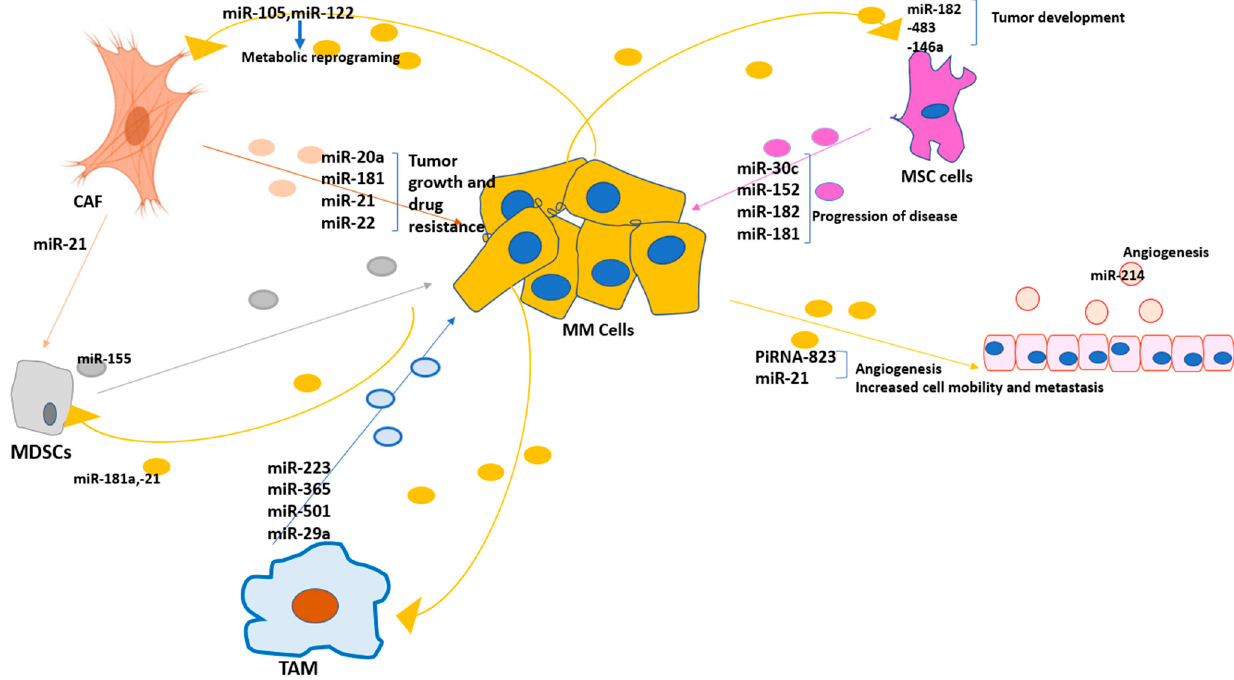
Figure 2. Schematic representation of the potential exosomal miRNA-mediated interactions in the BM microenvironment. Exosomes mediate bidirectional crosstalks between the TME components through shuttling functional molecules, including exosomal miRNAs. MM cells release exosomes with oncomiR cargo that supports tumor progression and/or drug resistance, produces cancer-associated fibroblasts (CAFs), prevents apoptosis, promotes angiogenesis, promotes the expansion of myeloid-derived suppressor cells (MDSCs), and induces an immunosuppressive microenvironment. Other components, in turn, promote the proliferation and survival of tumor cells and support disease progression by the secretion of specific exosomal miRNAs.